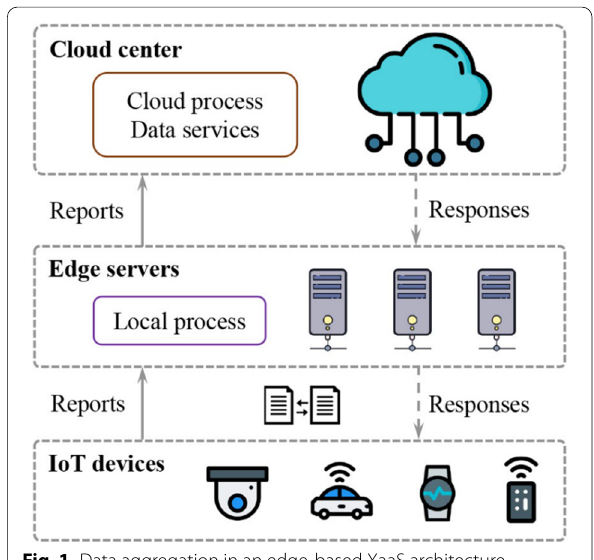
Fig. 1 Data aggregation in an edge-based XaaS